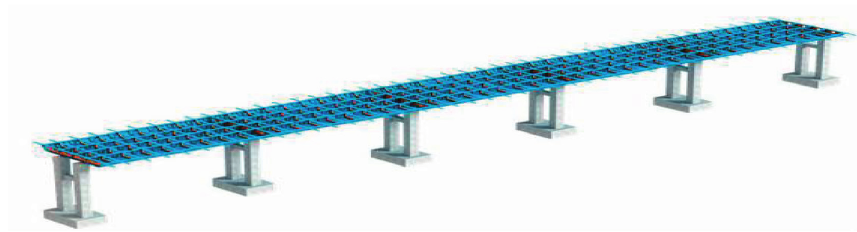
Figure 1: Structural layout of the fifth steel beam.